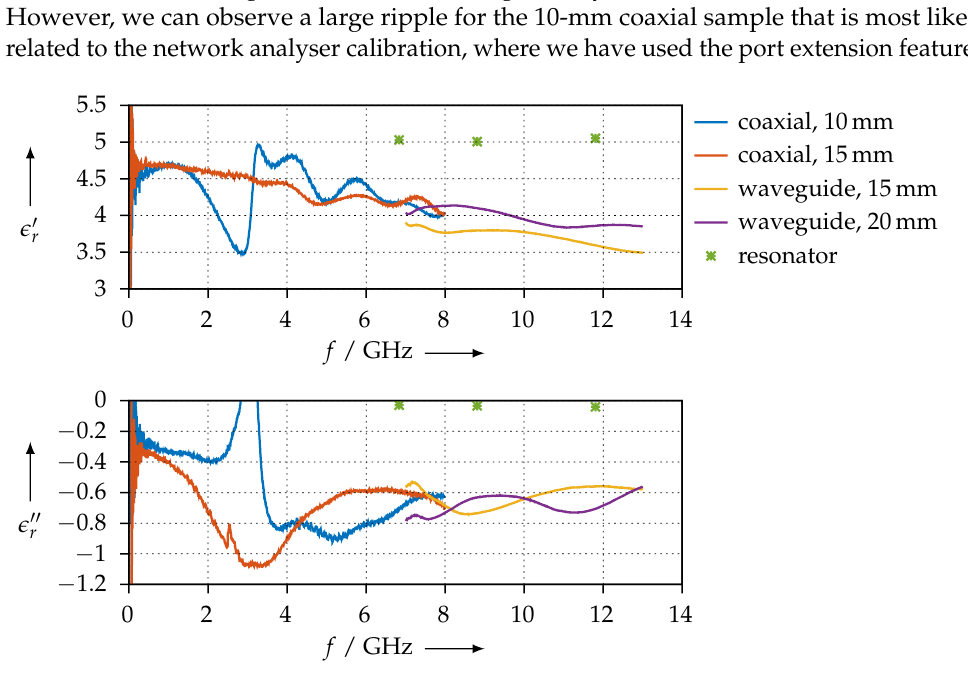
Figure 21. Real ( (cid:101) (cid:48) r ) and imaginary ( (cid:101) (cid:48)(cid:48) r ) parts of the permittivity for the FEP